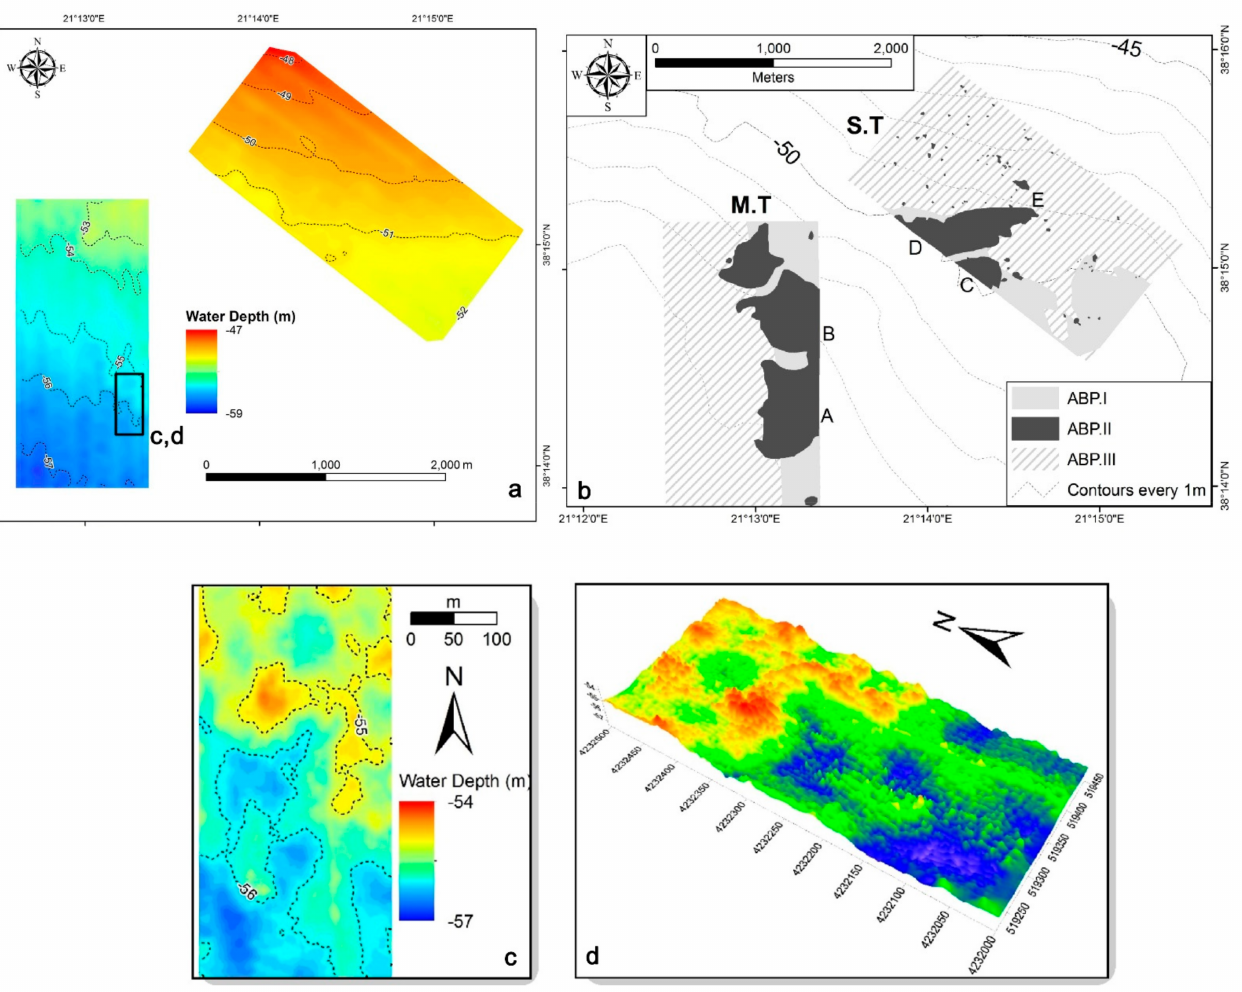
Figure 2. ( a ) Bathymetric map of the two survey areas and location of Figure 2c,d. (b) Map showing the areal distribution of the three acoustic backscatter patterns in “many target” (M.T) and “small target” (S.T) areas deduced from the marine remote sensing survey (ABP.I: uniform soft seafloor, ABP.II: small mounds, ABP.III: long, linear to curvilinear features on the seafloor, A, B, C, D, E: mound clusters) (see also Figures 3 and 4), ( c ) enlarged bathymetric map, and ( d ) enlarged 3D bathymetric map (location is shown in Figure